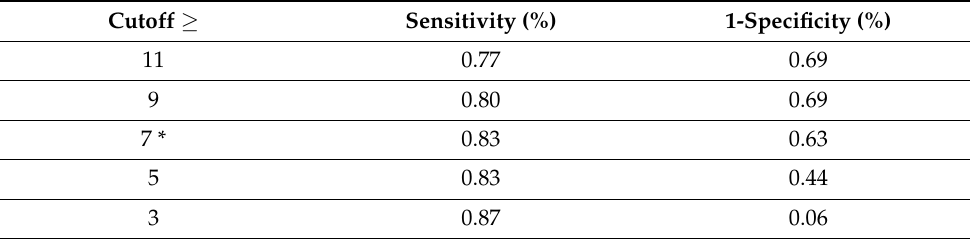
Table 3. The minimal important difference (MID) of chronic rhinosinusitis with nasal polyps impact on quality of life (CRSwNP-QoL) obtained with the receiver operating characteristics (ROC) analysis with different